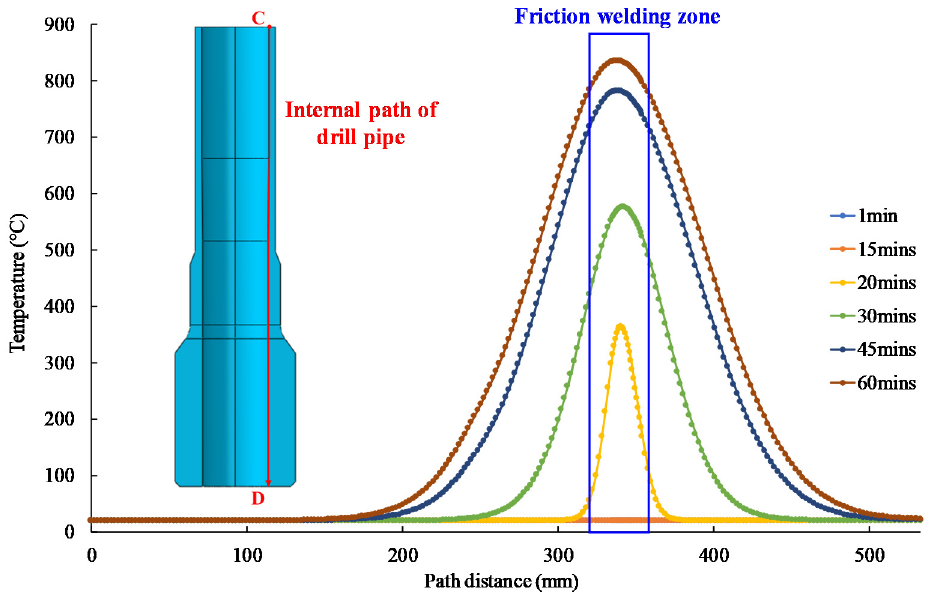
Figure 13. Temperature variation curves at different times along the inner wall path of drill pipe.